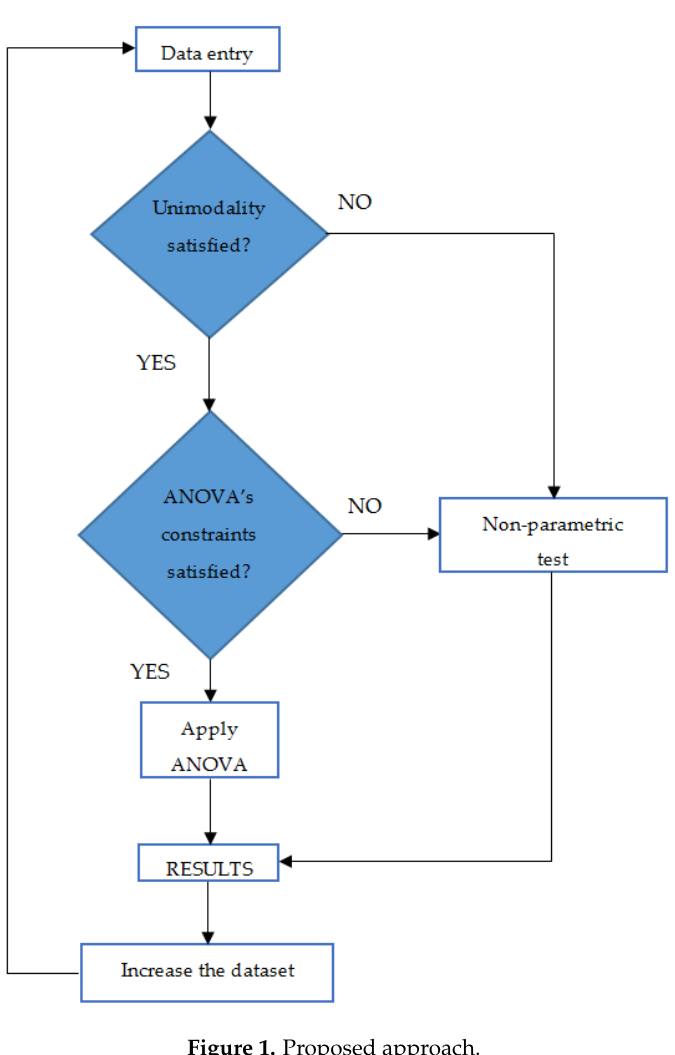
Figure 1. Proposed approach.